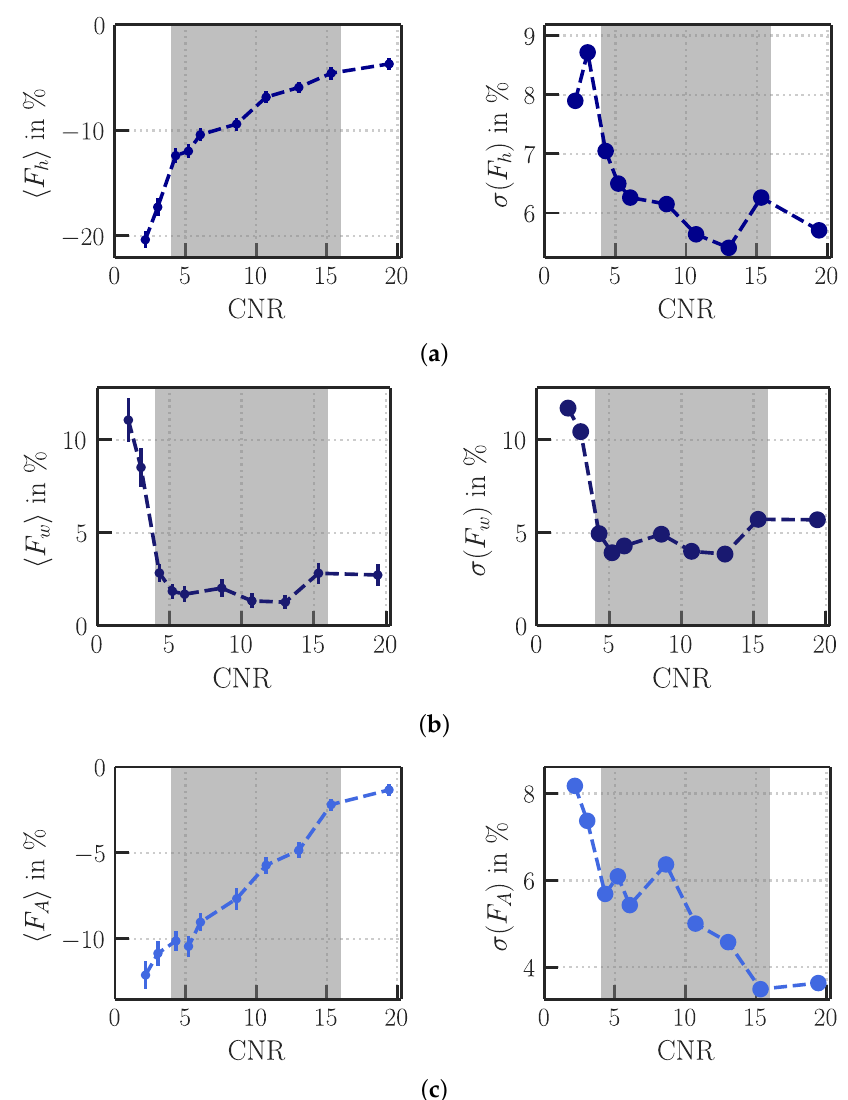
Figure 11. Left : Mean relative deviation of ( a ) the wedges’ heights (cid:104) F h (cid:105) , the wedges’ widths (cid:104) F w (cid:105) ( b ) and wedges’ areas (cid:104) F A (cid:105) ( c ) for each CNR value with n = 100 trials with randomly sized wedges. The error bar indicates the standard deviation of the mean, and the gray region shows realistic CNR values found in real thermograms. Right : Standard deviation of all respective mean relative deviations in